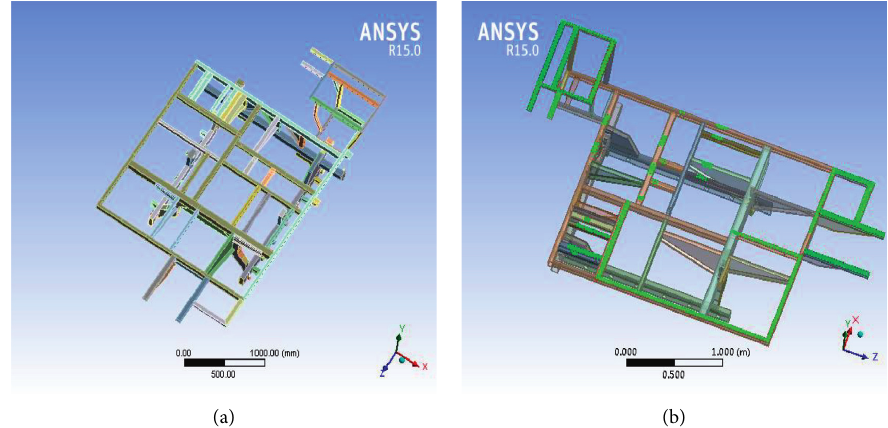
Figure 8: Crawler chassis frame model of ANSYS. (a) Imported chassis frame model. (b) Chassis frame bearing load mark diagram.